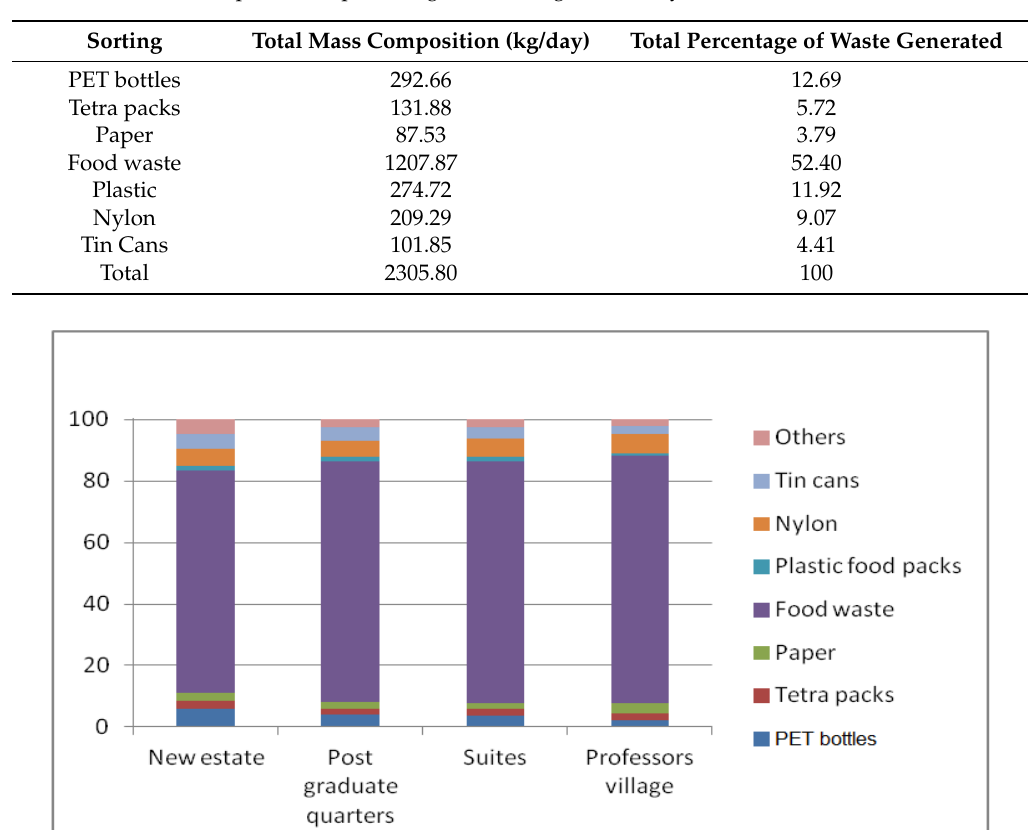
Table 6. Comparison of percentages of waste generated by residential areas for staff.